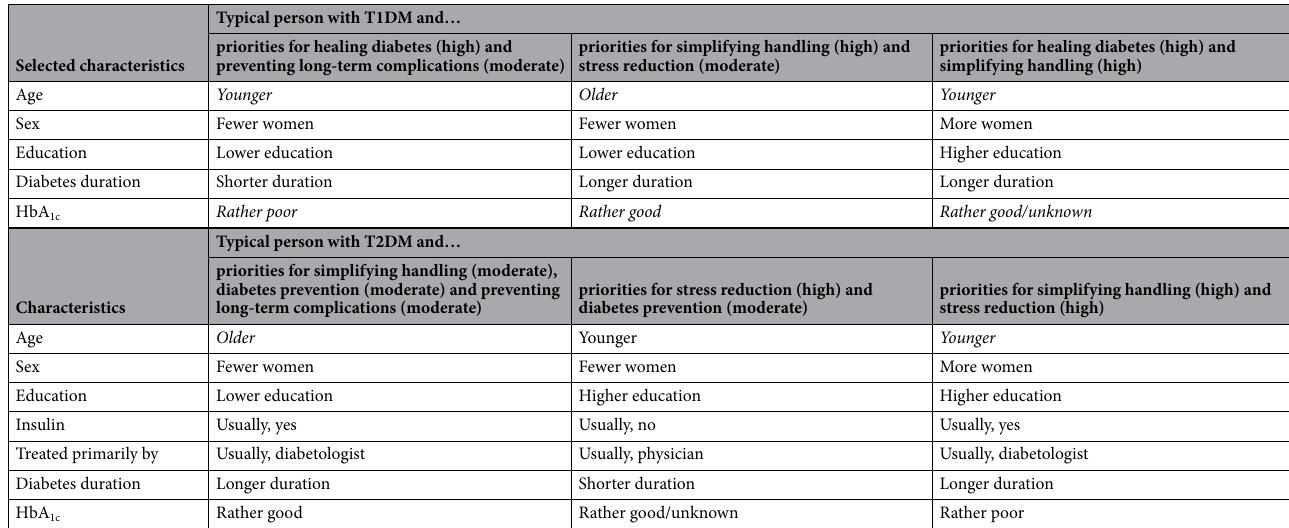
Table 3. Description of class characteristics compared to the other classes. The results were extracted from the LCA analysis (Table 2 and Supplementary Table S3). At level 5% significant results (Table 2) are marked with